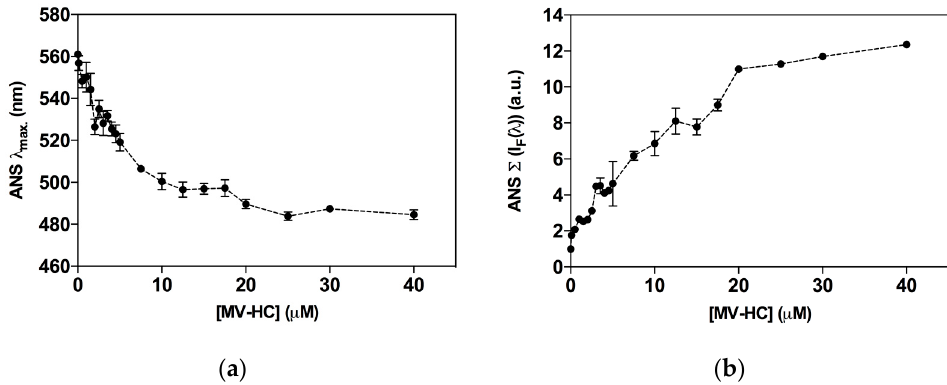
Figure 5. Aggregation of MV–HC evaluated by ANS fluorescence properties. The fluorescence emission maximum wavelength ( λ max ) ( a ); and the fluorescence intensity spectrum integral ( Σ [I F ( λ )]) ( b ) were plotted as a function of MV–HC concentration.